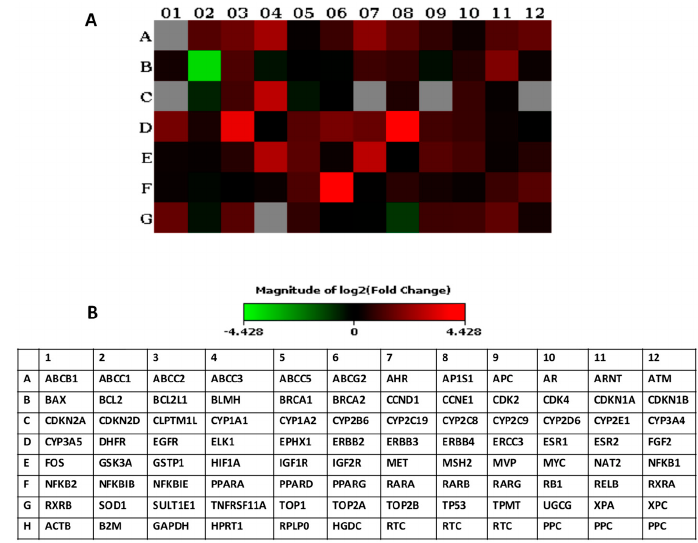
Figure 2. Multidrug resistant-related genes expression analyzed by RT2 profiler PCR array. ( A ) Heat map provides a visualization of the fold changes in the multidrug resistant-related genes expression in the MCF7_DoxR cells compared to the MCF7_DoxS cells. ( B ) Table showing the multidrug resistant-related genes used in the RT2 profiler PCR array experiments. HPRT1, B2M, and ACTB were used as housekeeping Table 1. The genes expression profiling of multidrug resistant-related genes in MCF7_DoxR compared to the MCF7_DoxS parental cells analyzed by RT2 profiler PCR array. A standard 2-fold change was used as arbitrary cut-off.